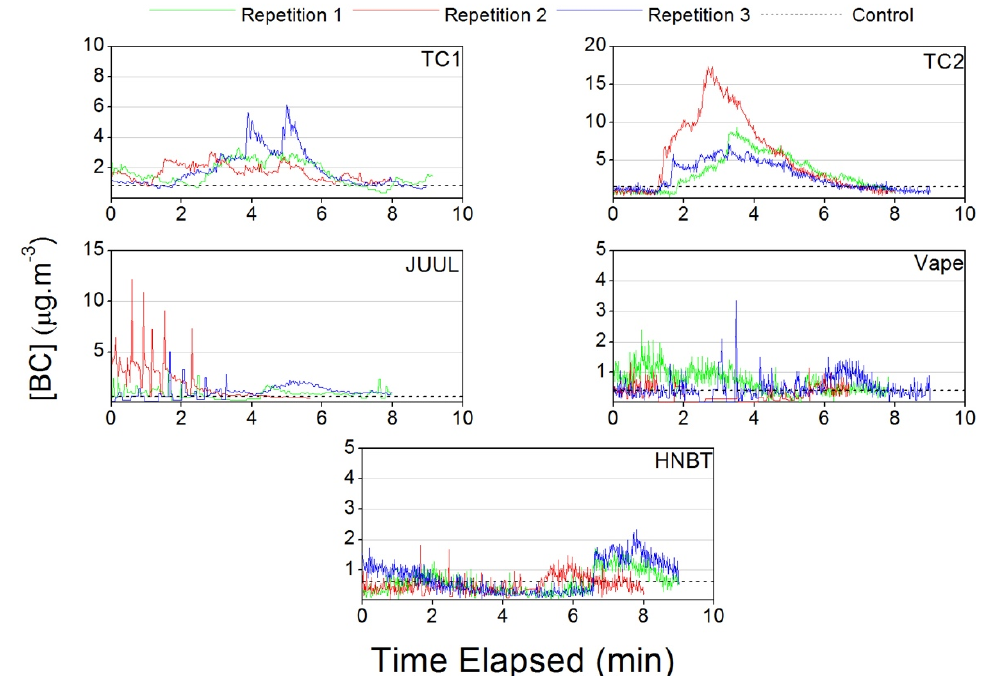
Figure 8. Black carbon concentrations measured in the car during traditional cigarette (TC1 and TC2), e-cigarette (JUUL and Vape) and heat-not-burn tobacco (HNBT) consumption.